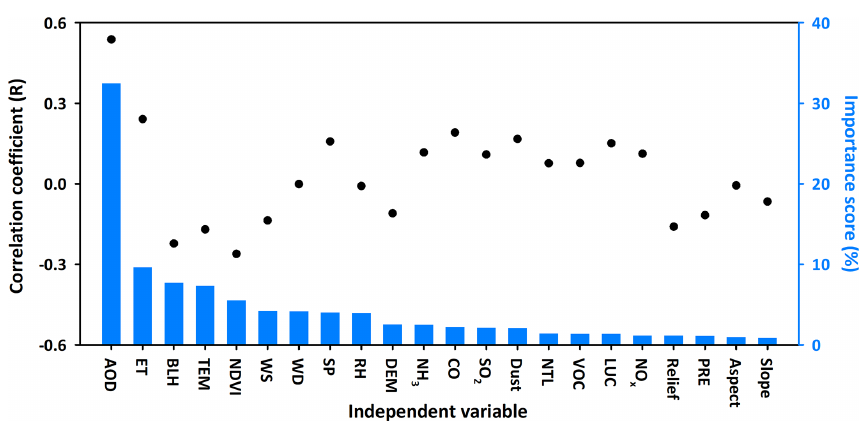
Figure 3. Potential effects and importance scores (blue bars; unit: %) of independent variables to PM 2 . 5 estimates for the STET